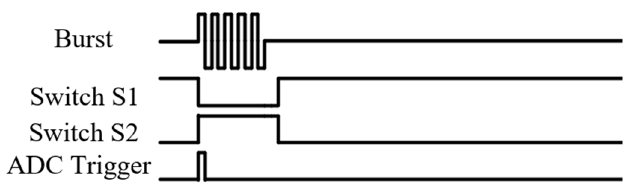
Figure 4. Sequence diagram of control.